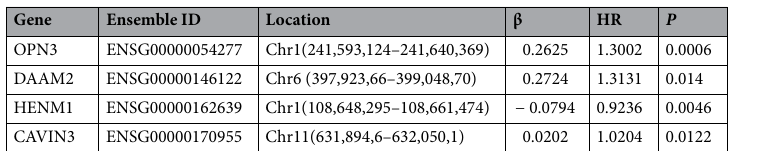
Table 1. The information of 4 mRNAs significantly associated with OS in CESC. β regression coefficient, HR hazard ratio, P P value (unadjusted).